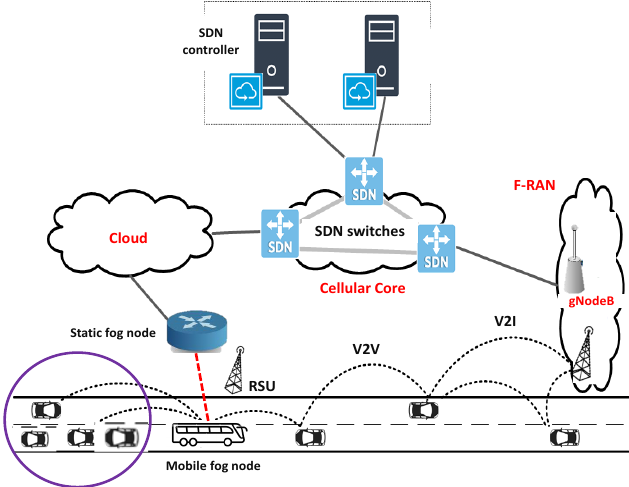
Figure 1. The hierarchical system architecture of